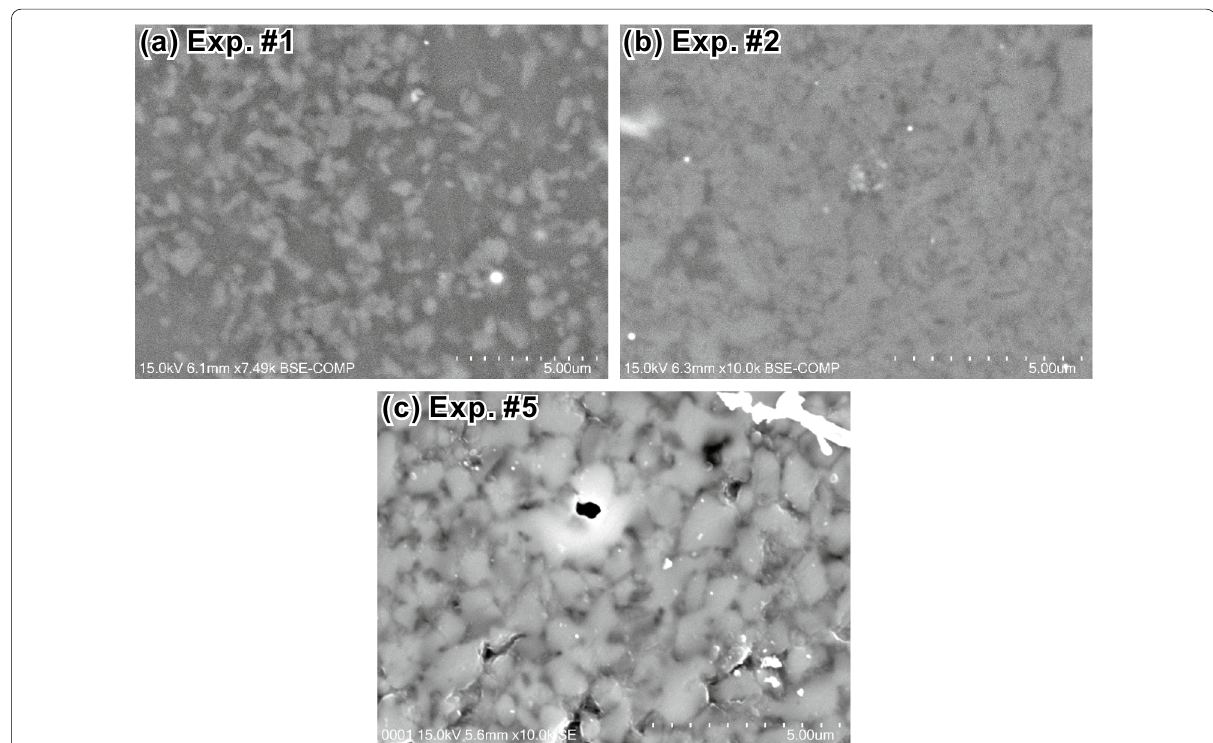
Fig. 6 SEM images of hot‑pressed samples prepared from the powders after 6 h of decantation. a Backscattered electron image (BEI) of the sample that was hot‑pressed at 50 MPa and 1150 °C (Exp. #1). b BEI of the sample that was hot‑pressed at 50 MPa and 1125 °C (Exp. #2). c Secondary electron image (SEI) of the sample that was hot‑pressed at 50 MPa and 1050 °C (Exp.